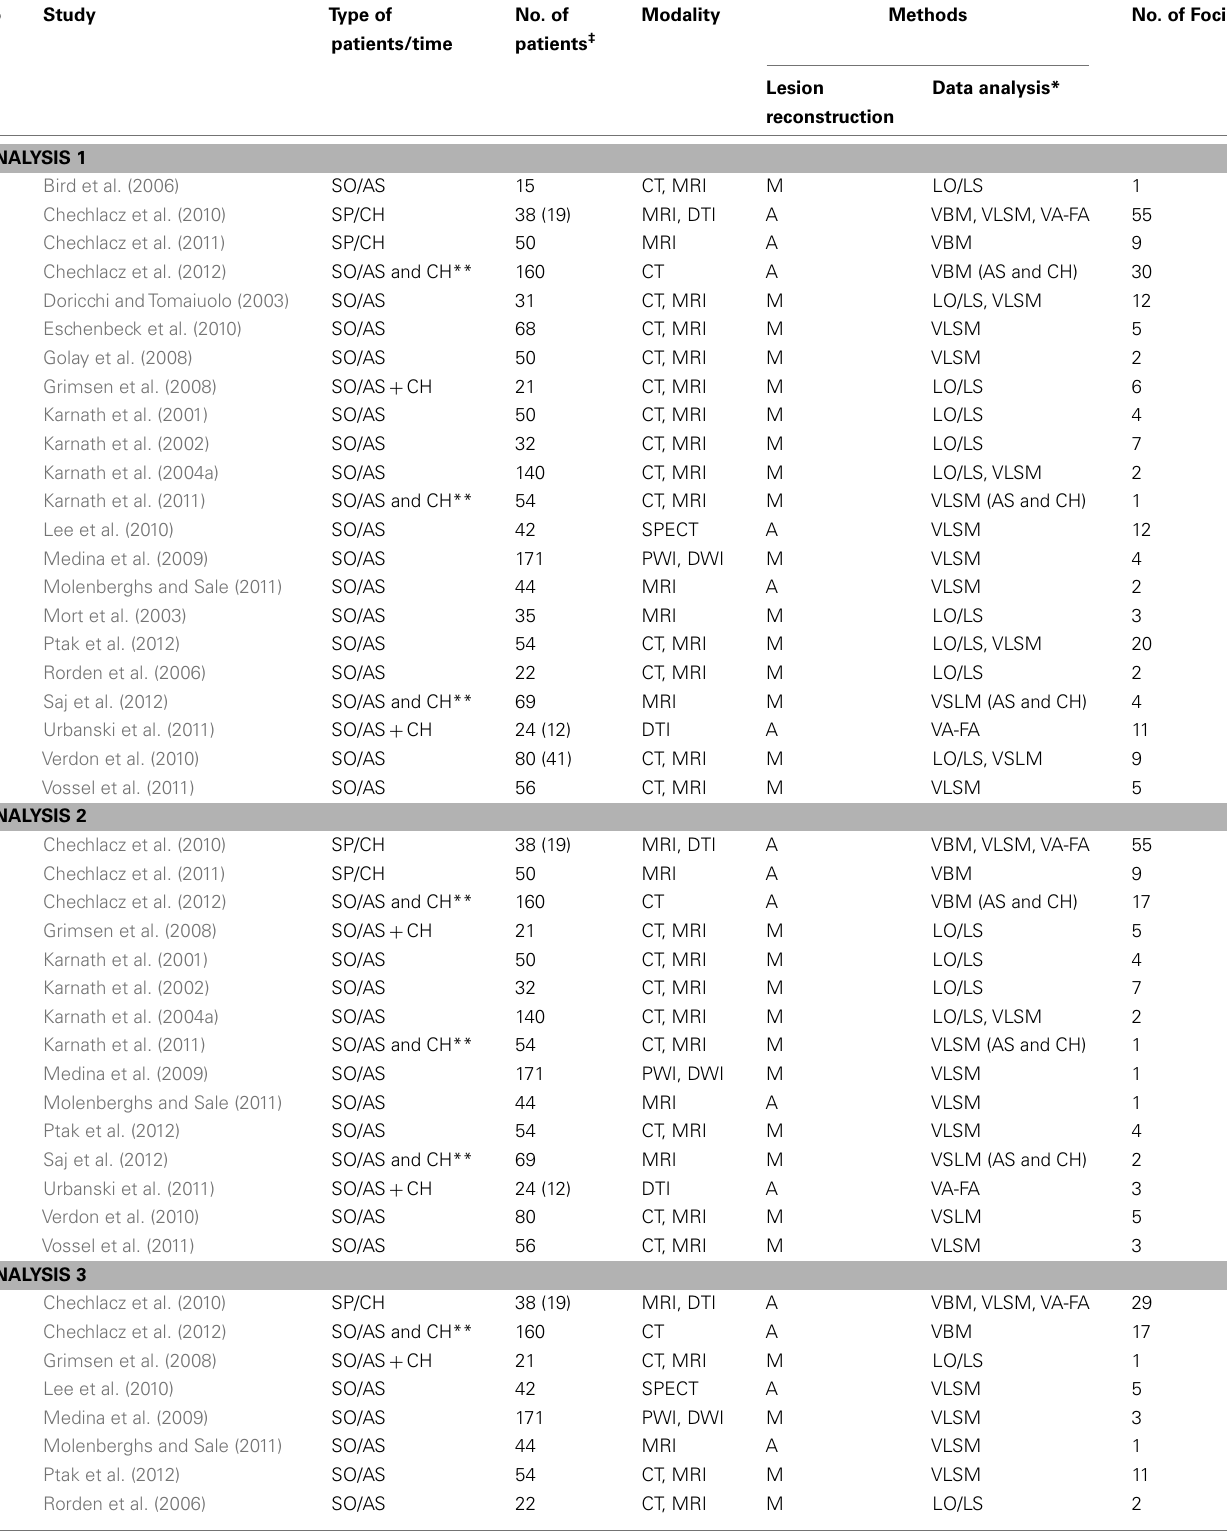
Table 1 | Studies included in theALE